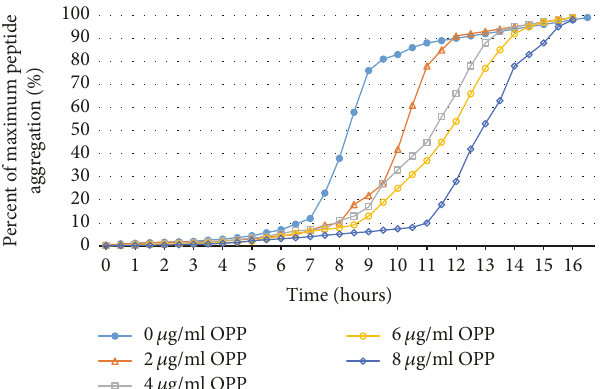
Figure 2: DLS kinetics of A 𝛽 aggregation inhibition by OPP. This figure reveals both the dose-dependent and time-dependent effects of inhibitory effects of OPP on A 𝛽 42 aggregation. Doses vary between 0 and 8 𝜇 g/ml OPP with kinetics studied over a 16-hour period of